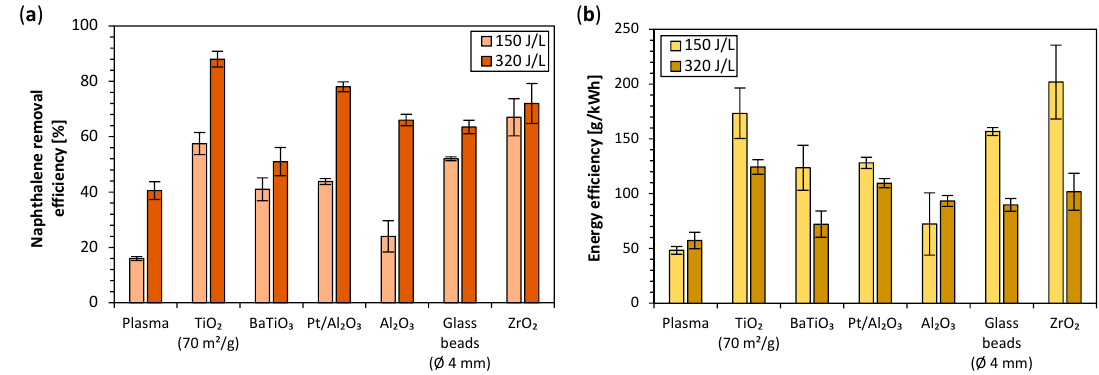
Figure 2. ( a ) Naphthalene removal efficiency and ( b ) energy efficiency for plasma and plasma catalytic reactors with various packing materials for the SIE of 150 and 320 J/L.